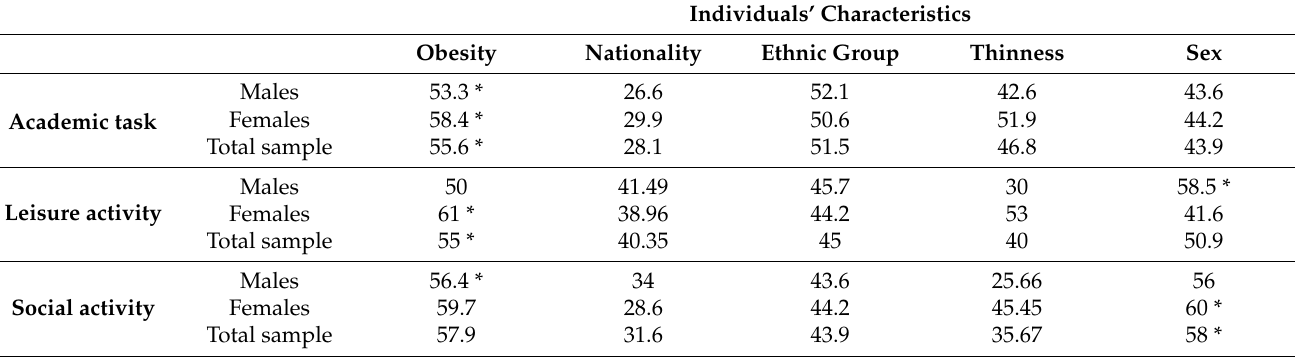
Table 1. Percentage of the sample that did not choose a schoolmate according to his/her characteristics for a specific activity (academic, social, or